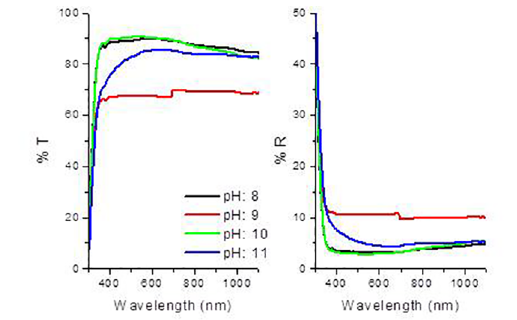
Figure 4. Transmittance and reflectance of MnSe thin films obtained from baths with different pHs.